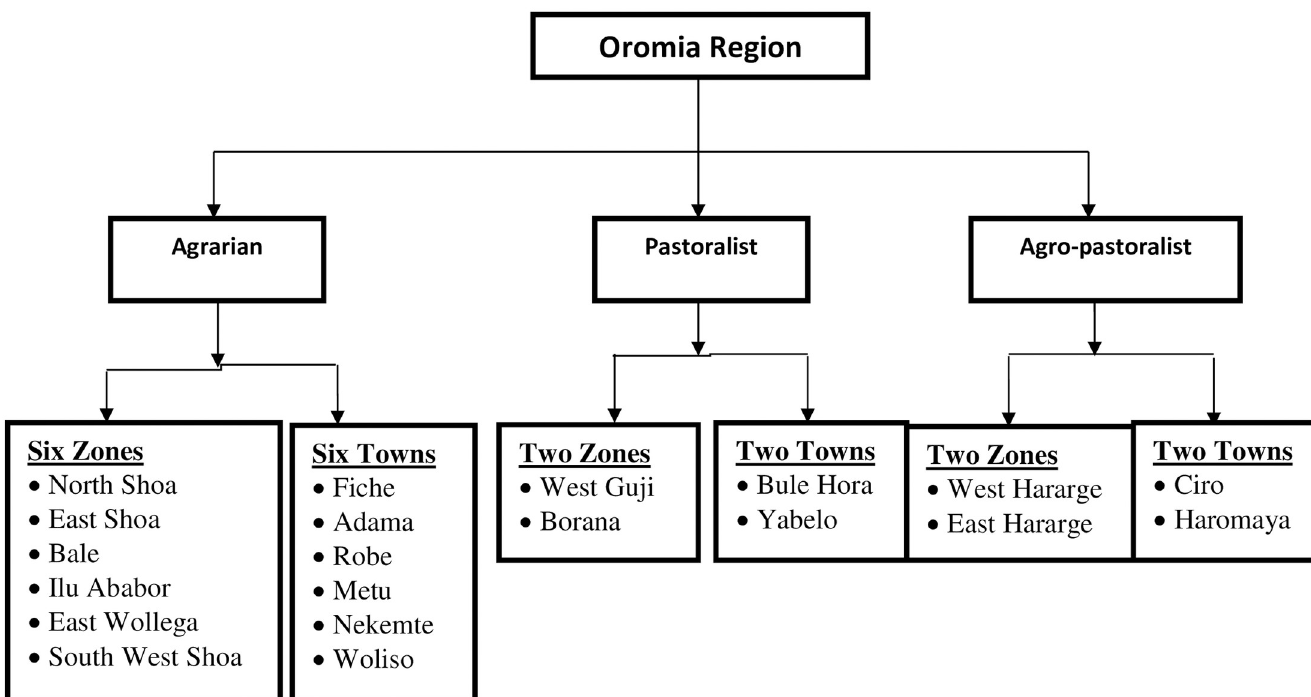
Fig 1. Schematic presentations of the sampling procedures to select the zones and towns, Oromia region, September 2020 to March 2021.